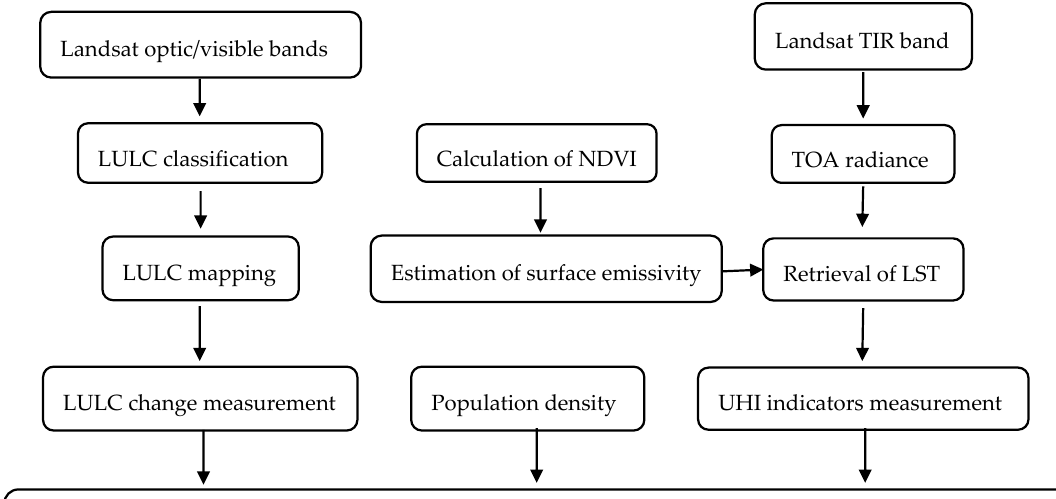
Figure 2. Overall working flowchart for this study.